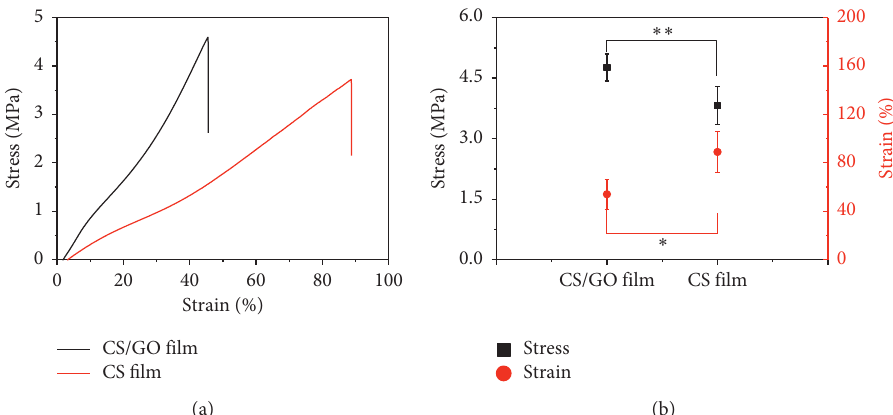
Figure 3: (a) Stress of CS film and CS/GO composite film as a function of strain; (b) stress and strain of CS film and CS/GO film just before fracture. ∗ p < 0 . 05 and ∗∗ p < 0 .